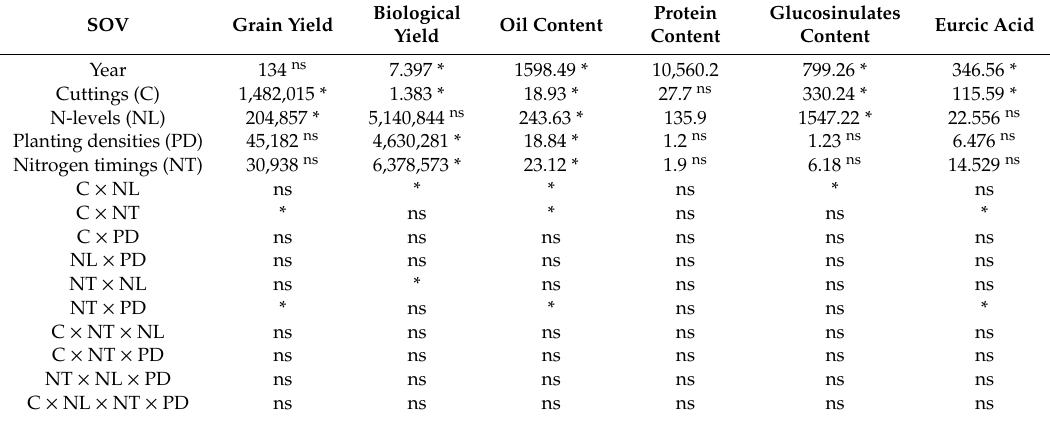
Table 2. Mean square table for crop yield, qualitative attributes, glucosinulates, and erucic acid for the years 2012–14.